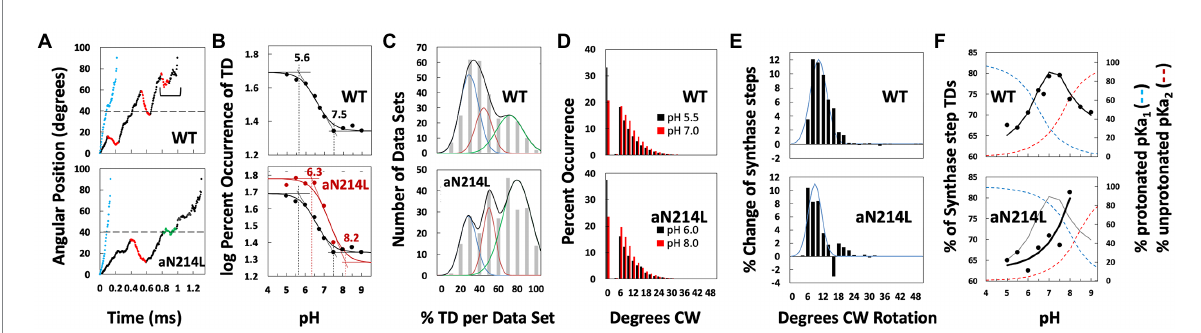
FIGURE 12 Characterization of F O transient dwells (TDs) and ATP-synthase direction steps in WT and the subunit-a N214L mutant. (A) Example F 1 F O ATPase-dependent power strokes without TDs (blue), and power strokes with TDs that contain (red) or lack (green) ATP synthase direction c-ring rotation relative to subunit-a plotted as degrees of rotation where 0 ° is the catalytic dwell and ATP-binding and/or ADP-inhibition occurs at ~35 ° . Brackets indicate Brownian-type oscillations during a TD. (B) Average TDs per data set vs. pH showing pKa values for WT (black) and aN214L (red). (C) . Distributions at pH 6.0 of the percent of TDs per power stroke data set (gray bars) where each data set contained ~300 power strokes that were collected from ~50 different F 1 F O molecules, and data were binned in 10% increments. The data were fit to the sum of three Gaussians (black line) representing low (blue), medium (orange), and high (green) TD formation efficiencies. (D) Distribution of the extent of CW synthase-direction rotation during TDs at the low and high pH values where the percent of synthase-direction steps was maximum and minimum. (E) Gaussian distributions (blue) of the difference between low and high pH values from D in extent of CW synthase-direction step rotation. (F) Percent of TDs containing CW synthase-direction steps vs. pH where data were fit to the sum of Henderson–Hasselbalch curves (black) resulting from the fraction of protonated groups with pKa 1 (blue) and unprotonated groups with pKa 2 (red) vs. pH. This figure was modified from Yanagisawa and Frasch,